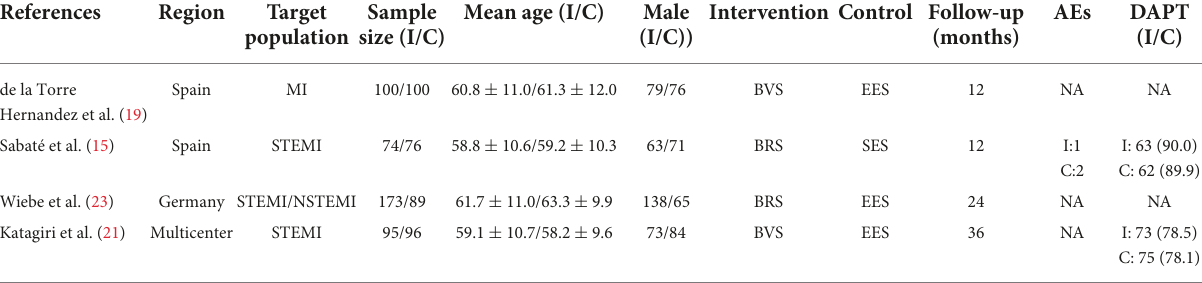
TABLE 1 Clinical characteristics of included trials.